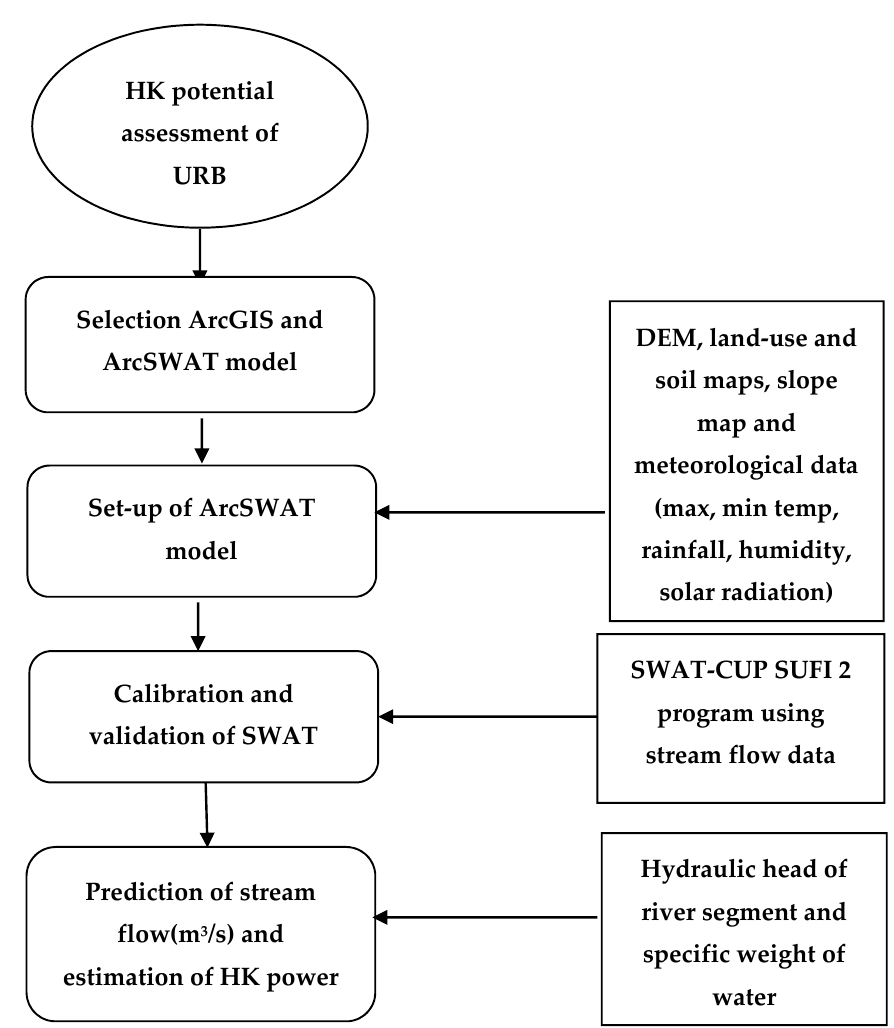
Figure 2. Overview of the adopted